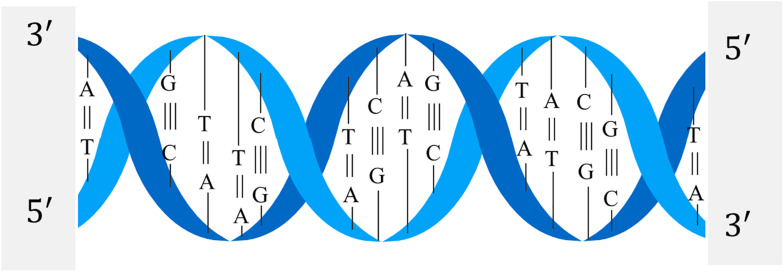
Double helix of DNA.